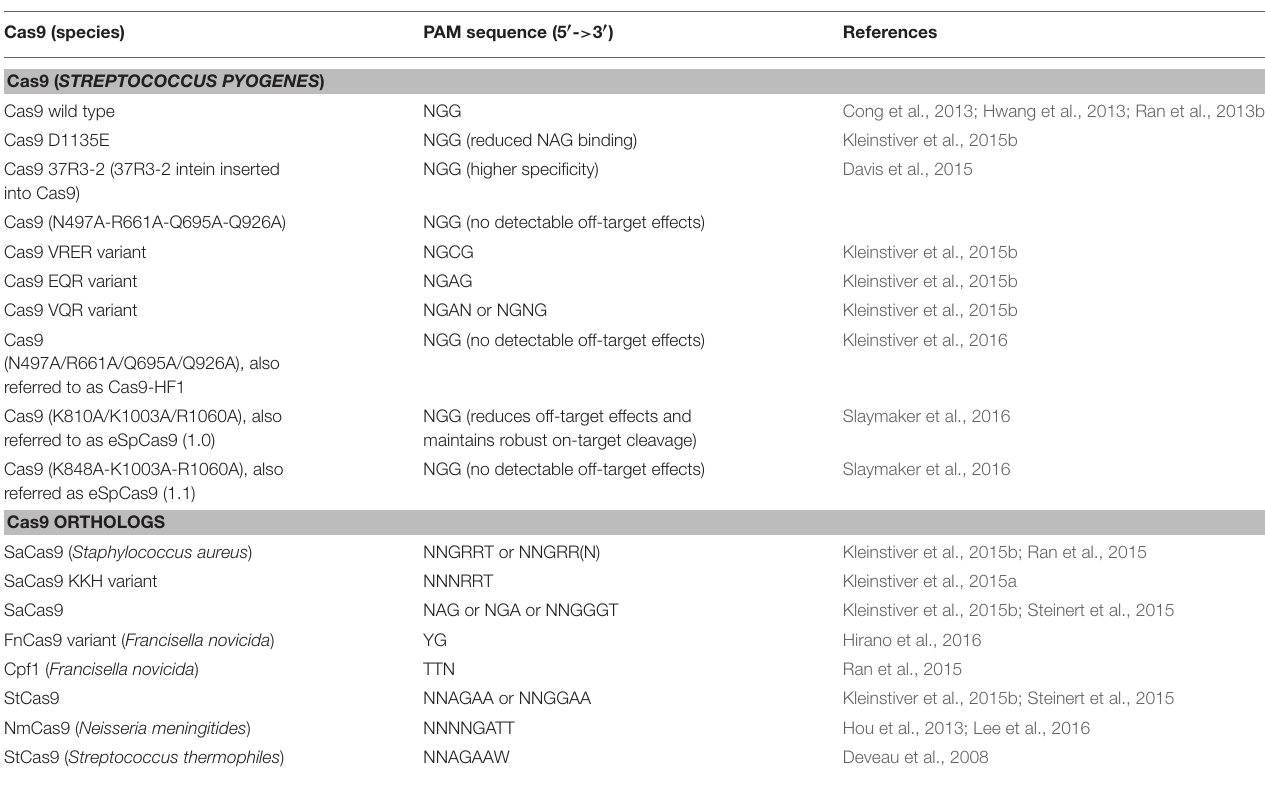
TABLE 1 | Cas9 variants and orthologs for genome